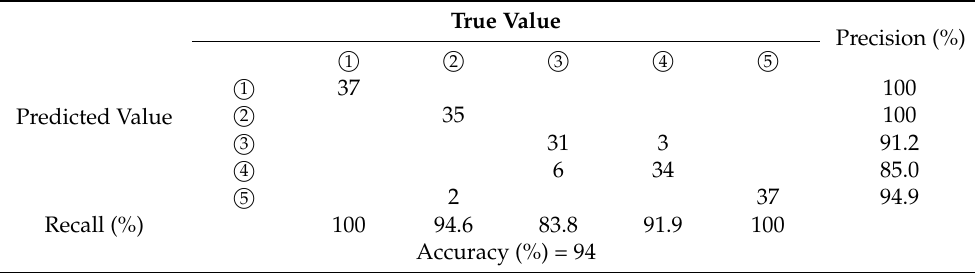
Table 5. Table of identification accuracy results for key construction scenes on bridges, where: 1 (cid:13) denotes construction surveying and proofing, 2 (cid:13) denotes embedding steel casing, 3 (cid:13) denotes erection of formwork and stand, 4 (cid:13) denotes steel bar welding and binding, and 5 (cid:13) denotes beam transportation and assembly. True Value Precision (%) 1 (cid:13) 2 (cid:13) 3 Predicted Value